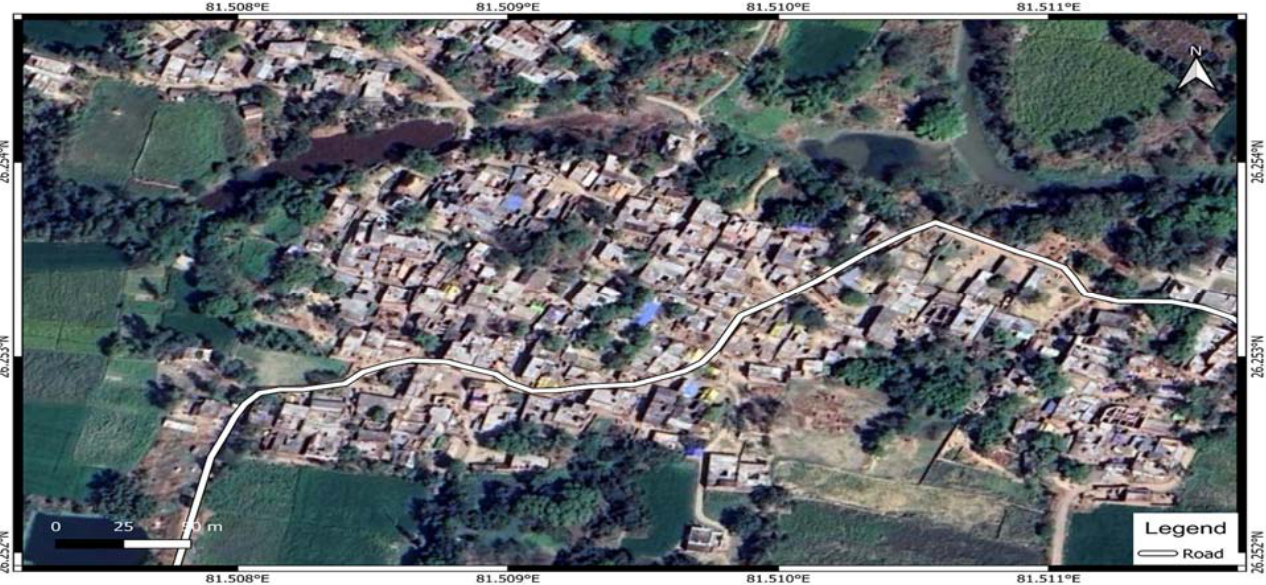
. Figure 4. Study area location at Bahadurpur. Figure 5. Data collection and questionnaire at (a) Pure Ganga Gaon (b) Bahadurpur